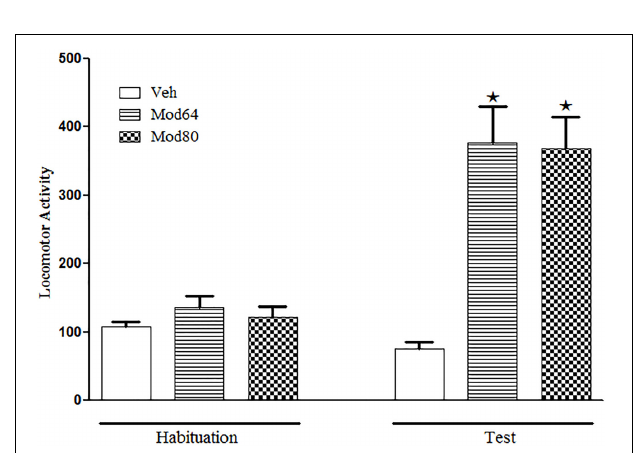
FIGURE 3 | Locomotor activity in the open field during the 3rd day of habituation and during the test session with vehicle or two different doses of modafinil. The animals received an injection of vehicle solution (Veh), 64 mg/kg (Mod64) or 80 mg/kg (Mod80) modafinil, and after 30 min, the locomotor activity was measured for 10 min in the open field. Data are reported as mean ± SEM. Veh ( n = 10), Mod64 ( n = 9), and Mod80 ( n = 10). (cid:70) P < 0.05 compared with the Veh